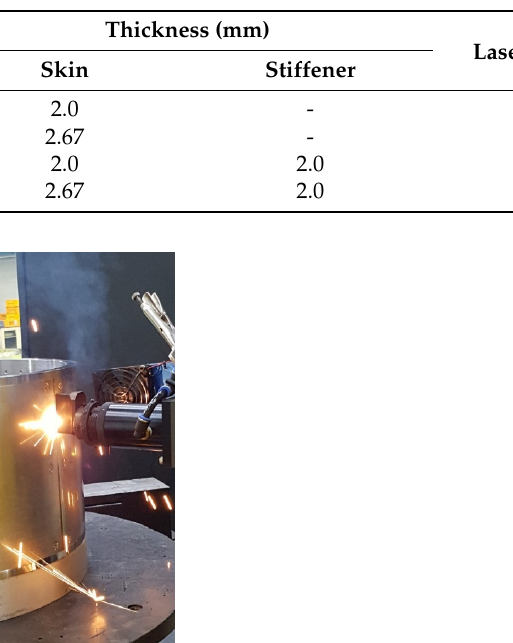
Table 2. Laser welding condition.